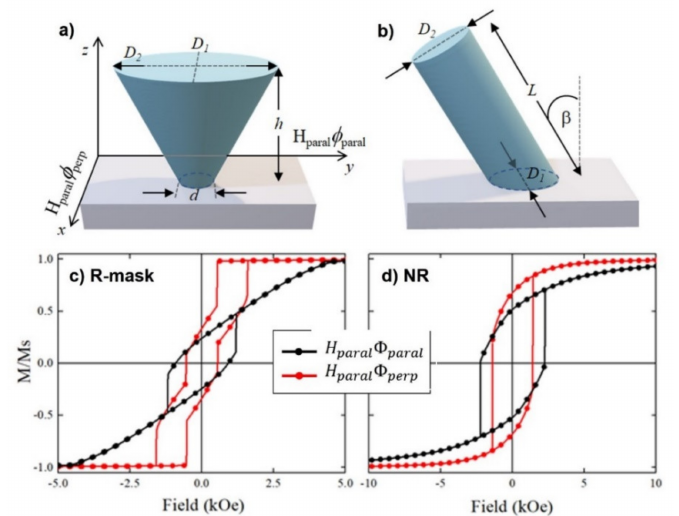
Figure 6. Diagram and geometric parameters of the nanostructures used to model the ( a ) R-mask sample and the ( b ) NR sample in the micromagnetic simulations. Simulated hysteresis loops for R-mask ( c ) and NR ( d ) samples when a magnetic field is applied parallel ( H paral Φ paral , black dots) and perpendicular ( H paral Φ perp , red dots) to the direction of the atomic flux projection during deposition ( y -axis of the diagram) and with an uniaxial anisotropy perpendicular to the flux direction ( x -axis) with a magnitude of K u = 600 kJ/m 3